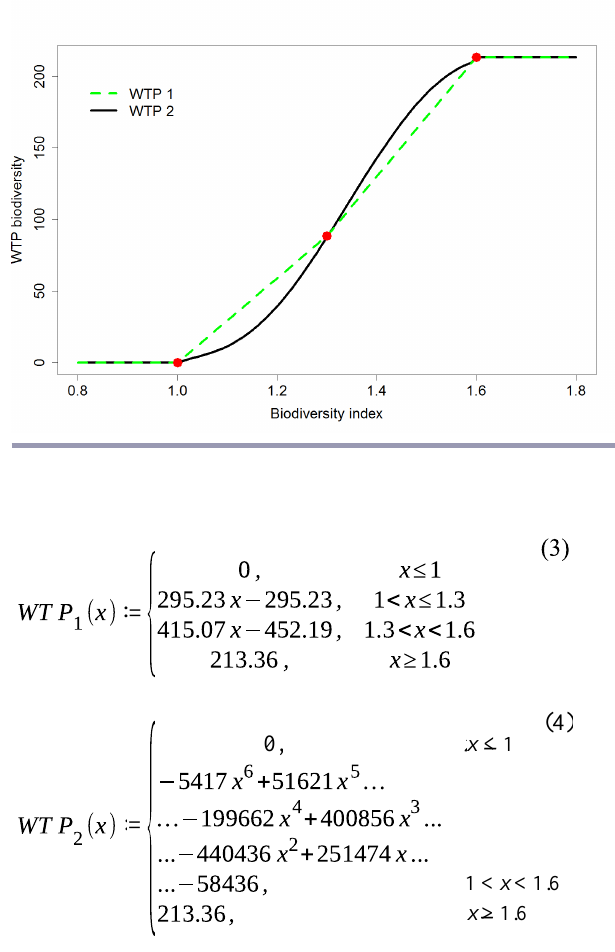
Fig. 2. Two possible willingness to pay (WTP) functions used in the study. The two functions (WTP 1 and WTP 2) describe WTP for a certain level of biodiversity; their shape was determined by the given data points